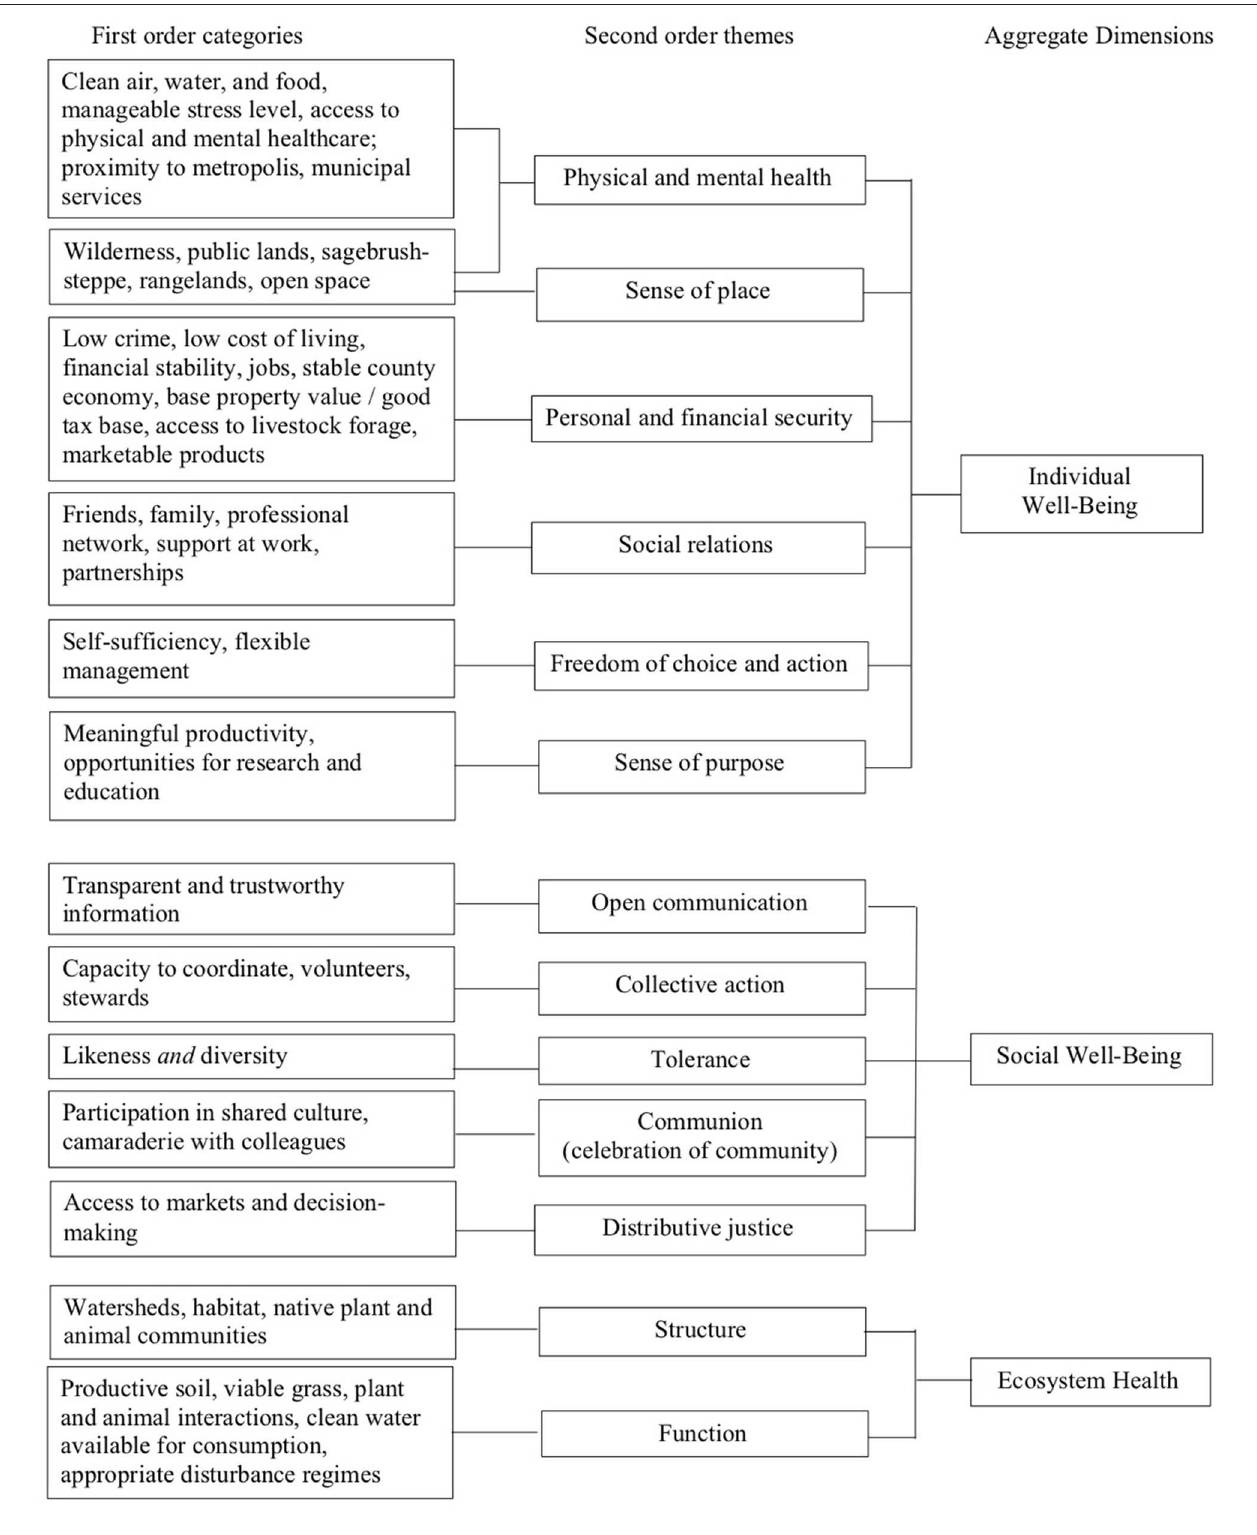
FIGURE 2 | Data Structure formed by iterative analysis to identify conditions and dimensions of human well-being and ecosystem health.